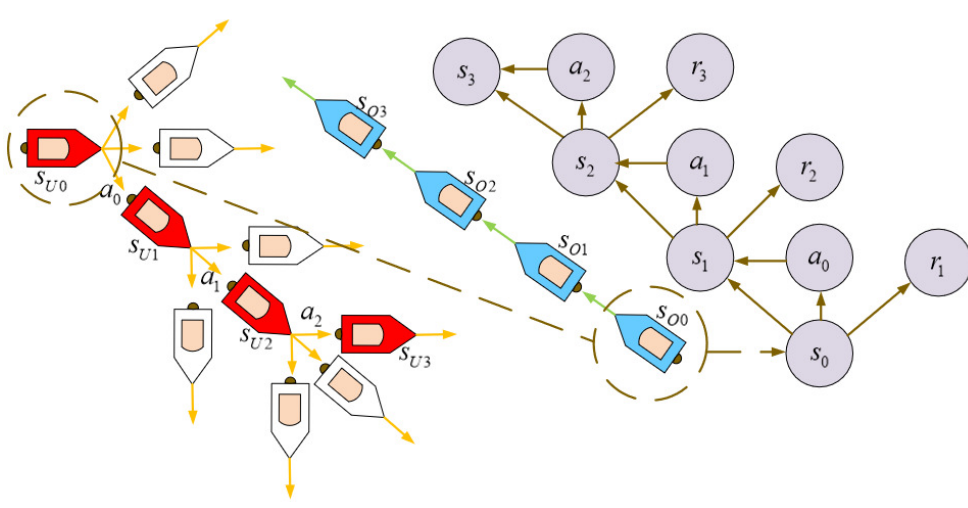
Figure 7. The update process of the USV collision avoidance